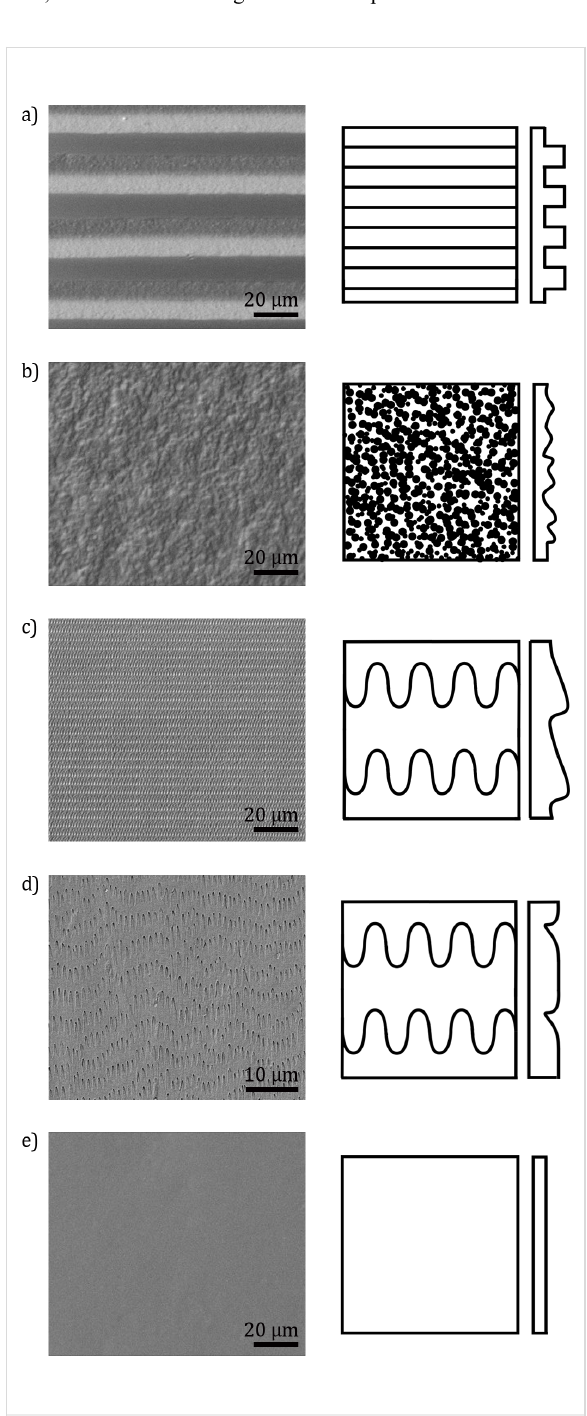
Figure 7: Exemplary overview of the topography of the examined polymer surfaces. Left column: SEM-micrographs. Right column: schematic top view and profile of the surface microstructure. a) Period- ical groove-like polymer surface – PGMS (pitch: 25 µm). b) Randomly- rough surfaces – RRS (grain size: 1 µm). c) Snake-inspired microstruc- tured polymer surface – SIMPS. d) Mold of the ventral scale of L. g. californiae - PMLG. e) Smooth